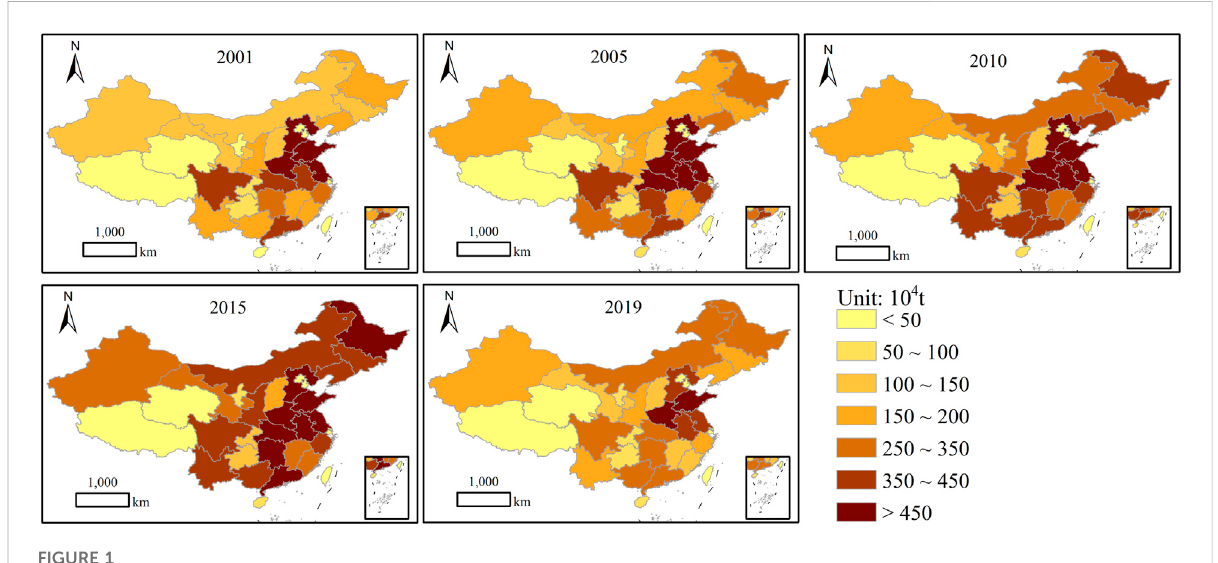
FIGURE 1 Agricultural carbon emissions by province (2001, 2005, 2010, 2015 and